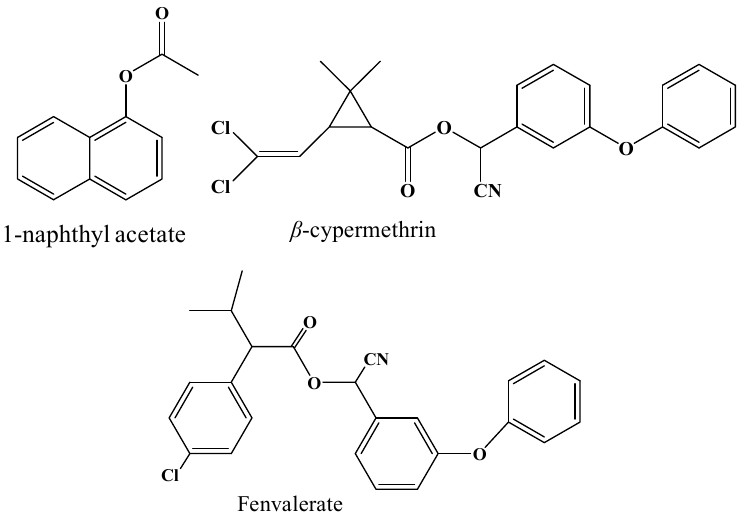
Figure 5. Structures of 1-naphthyl acetate, fenvalerate, and β -cypermethrin used in this paper.